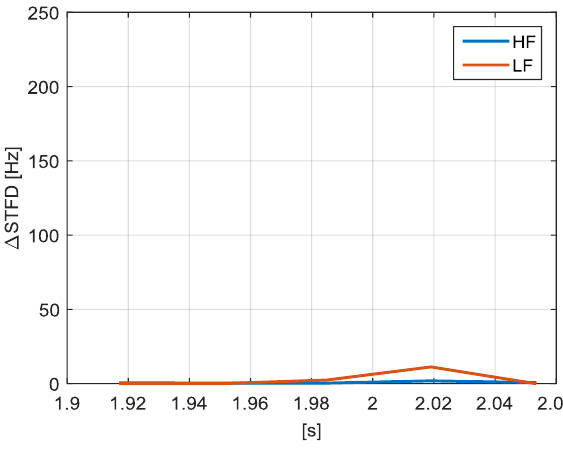
Figure 38. Case study 3: Δ STFD at low-frequency (0 ÷ 2.4 kHz, red line) and at high-frequency (2.4 ÷ 150 kHz, blue line) obtained through STFT.